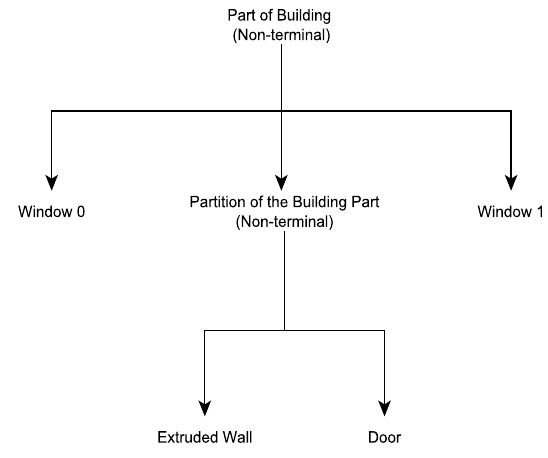
Figure 3: Example of a tree structure from building model deriva- tion according to the split